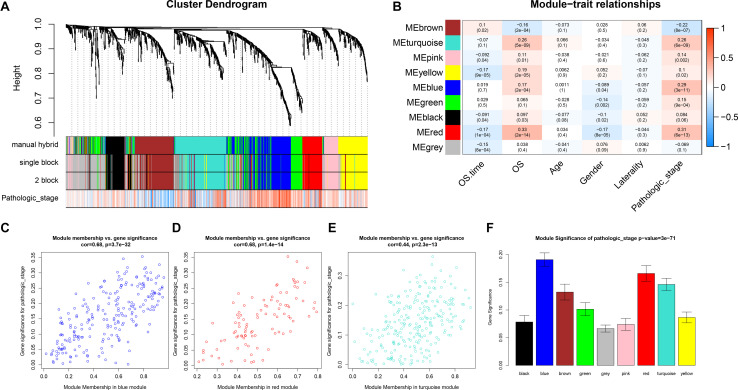
Identification of relevant modules associated with clinical information. (A) Dendrogram of all differentially expressed genes clustered based on a dissimilarity measure (1-TOM). (B) Heat map of the correlation between module eigengenes and different clinical information of ccRCC (OS time (overall survival time), OS (overall survival status, age, gender, laterality, and pathologic stage). (C) Scatter plot for correlation between gene module membership in the blue module (pathologic stage) and gene significance. (D) Scatter plot of MEs in red module. (E) Scatter plot of MEs in turquoise module. (F) Distribution of average gene significance and errors in the modules associated with the progression of ccRCC.